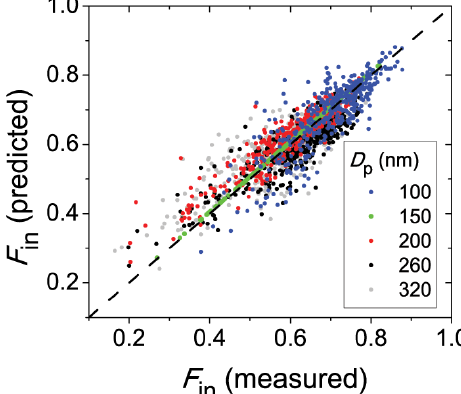
Fig. 9. Measured and predicted F in over 100nm to 320nm (2145 data points). The dashed line represents the 1 : 1